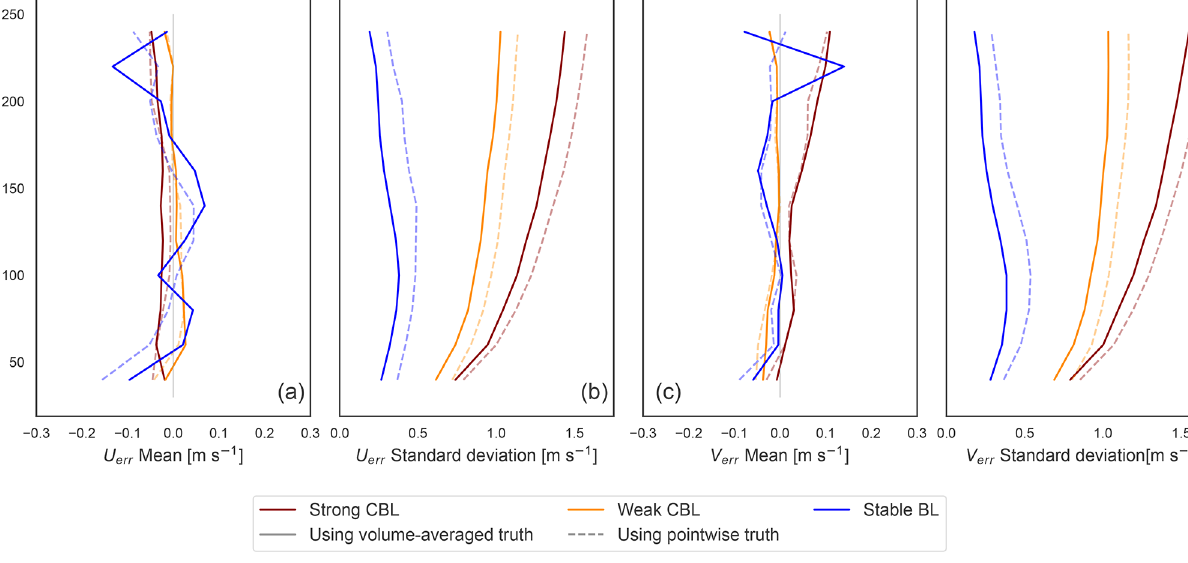
Figure 7. Mean and standard deviation of error in the u (a, b) and v (c, d) horizontal velocity components using both volume-averaged truth (solid) and pointwise “tower” truth (dashed). Stability cases are distinguished by line